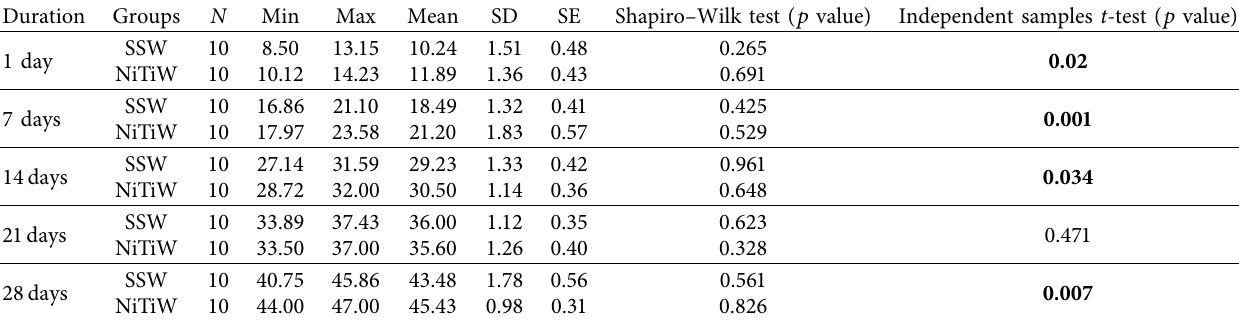
Table 2: Comparison of the CHX elusion ( μ mole) of coated SSW and NiTiW.